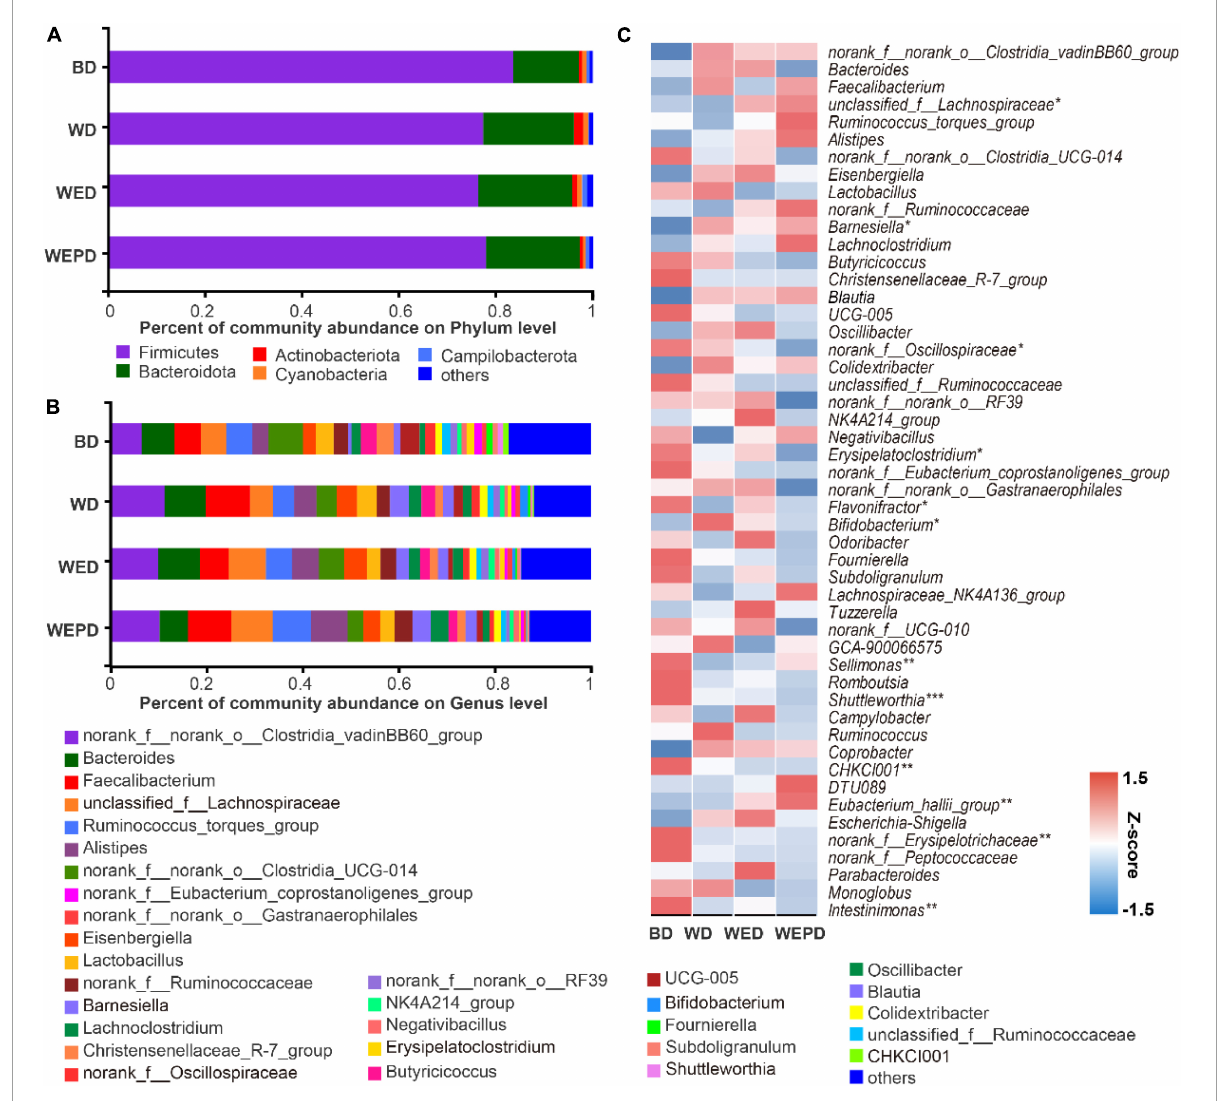
FIGURE3 Community composition analysis. Phylum (A) and genus (B) level relative abundance, and trends change (C) of microbiota (phylum level) from the cecal digesta of broilers fed different